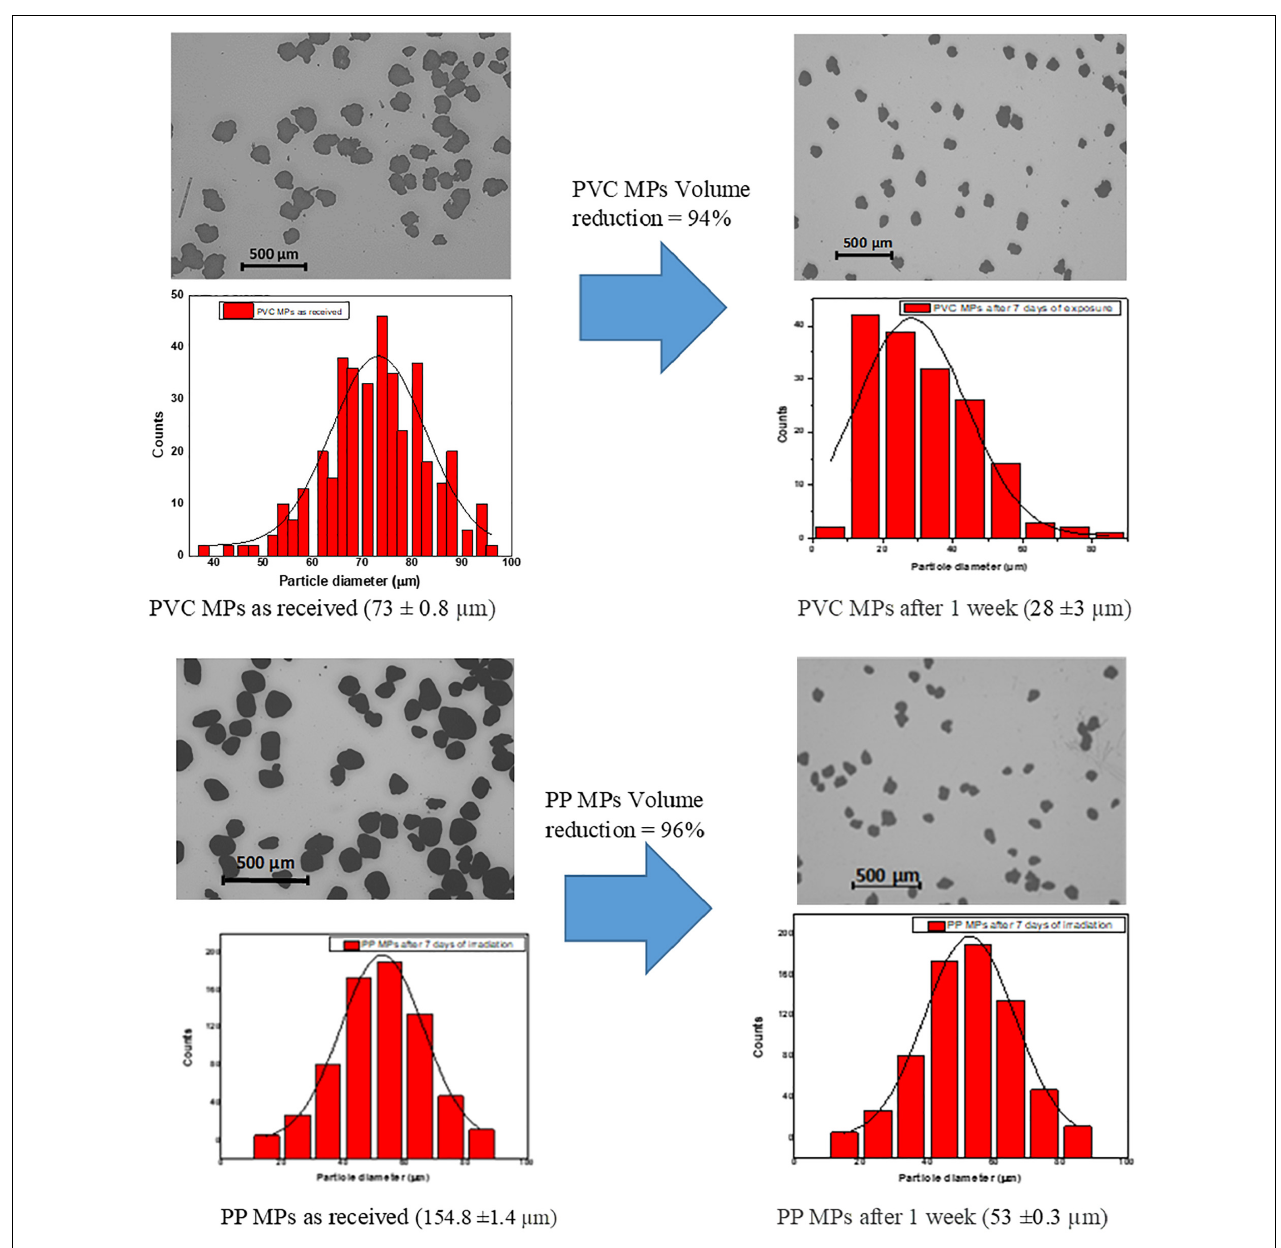
FIGURE 5 | Optical Microscope images and particle size distribution before and after visible light irradiation of PVC and PP microplastics.